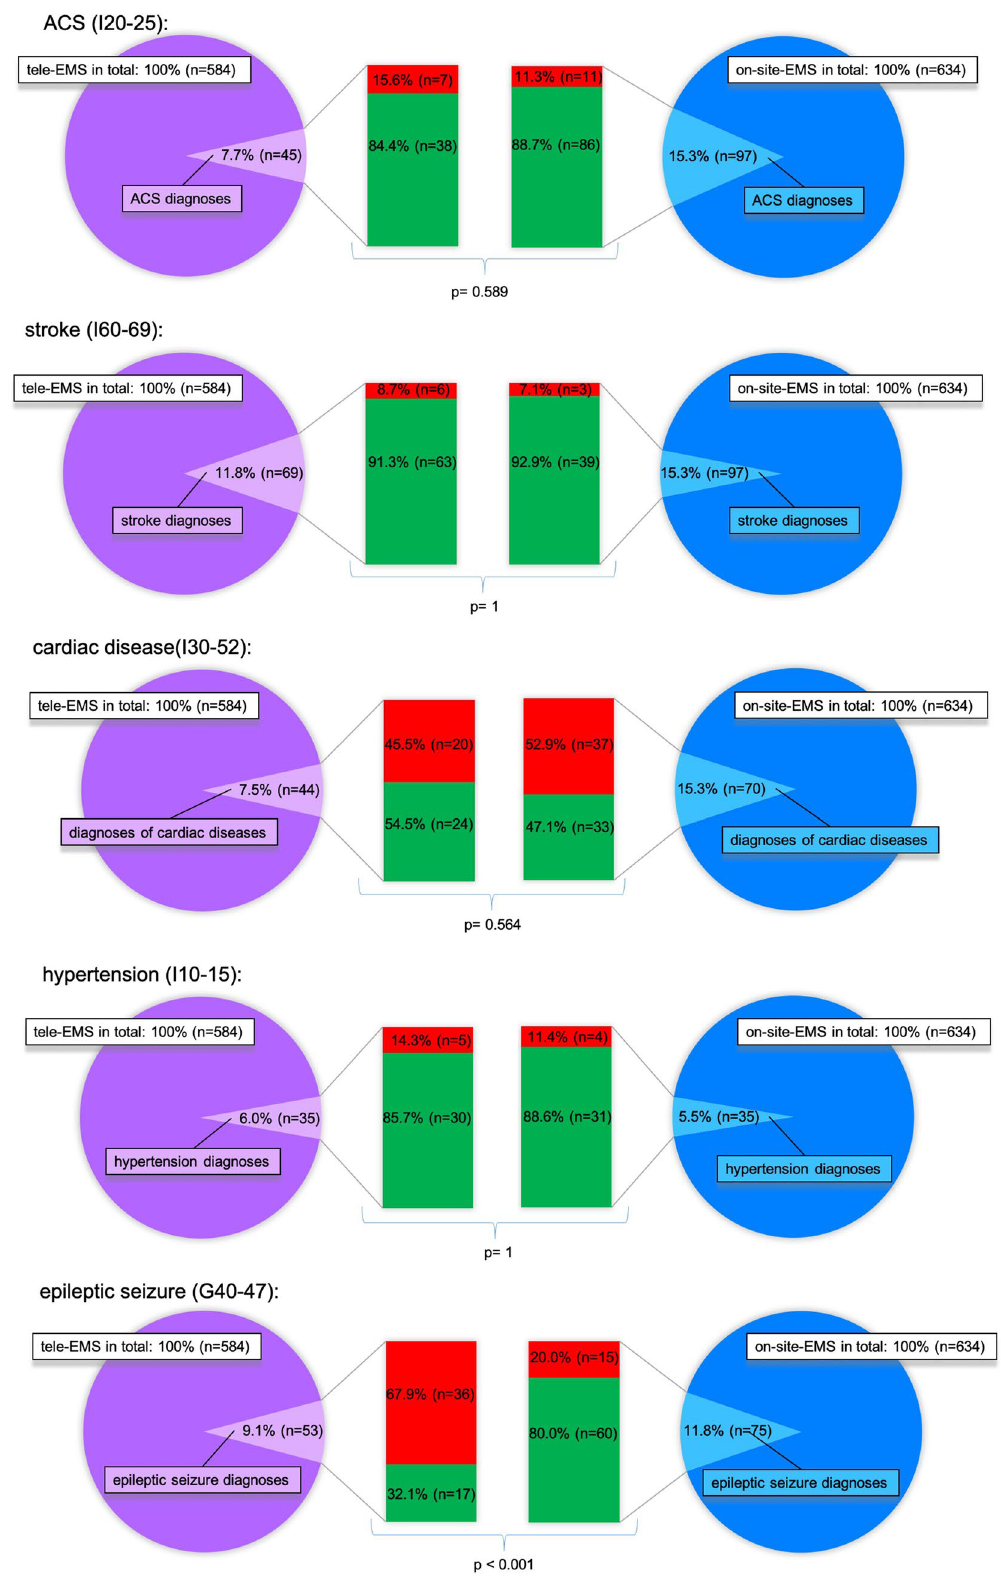
Figure 2. Diagnostic con- and miscordance. This figure shows matches (green bars) and fails (red bars) regarding diagnosis from the tele-EMS physician and the on-site-EMS physician compared with the final hospital diagnosis based on the hospital information